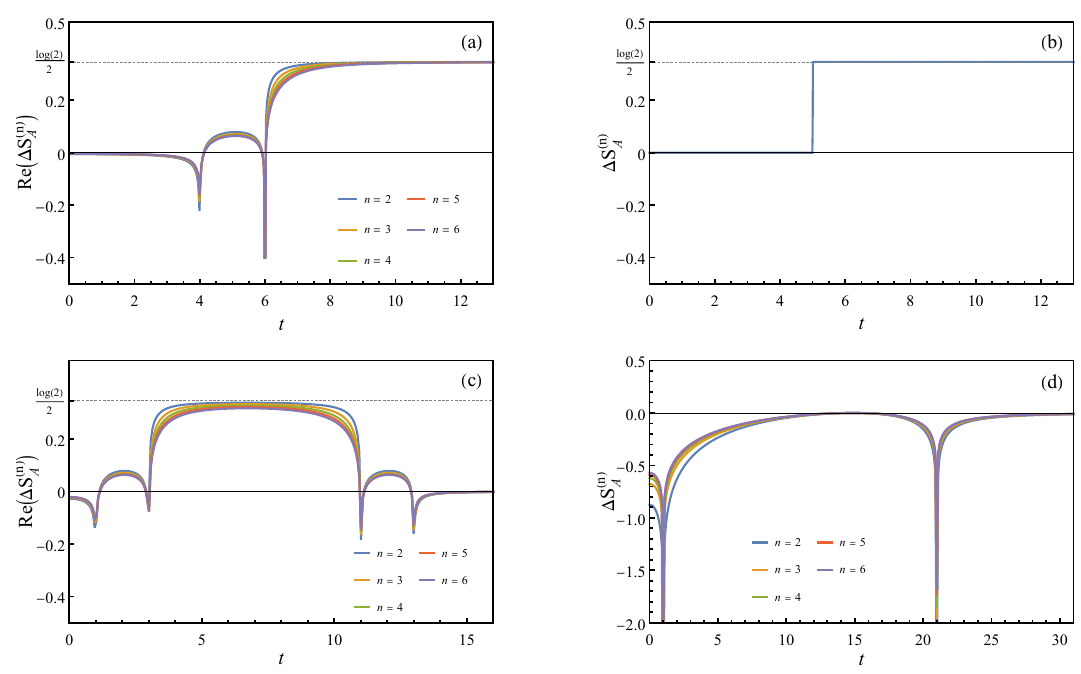
Figure 7. The real-time evolution of Re [∆ S ( n ) The regulator (cid:15) = 10 − 5 . (a): A = [0 , ∞ ) , x m = ± 5 , l = 2 ; (b): A = [0 , ∞ ) , x m = 0 , l = 10 ; (c): A = [0 , 10] , x m = − 2 or 12 , l = 2 ; (d): A = [0 , 20] , x m = 10 , l = 22